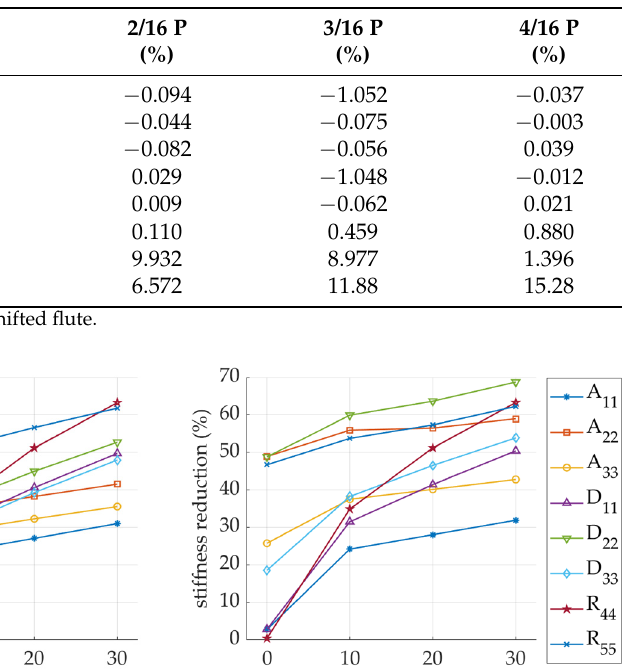
Table 11. Uncut samples DW. Stiffness reduction in terms of flute offset.